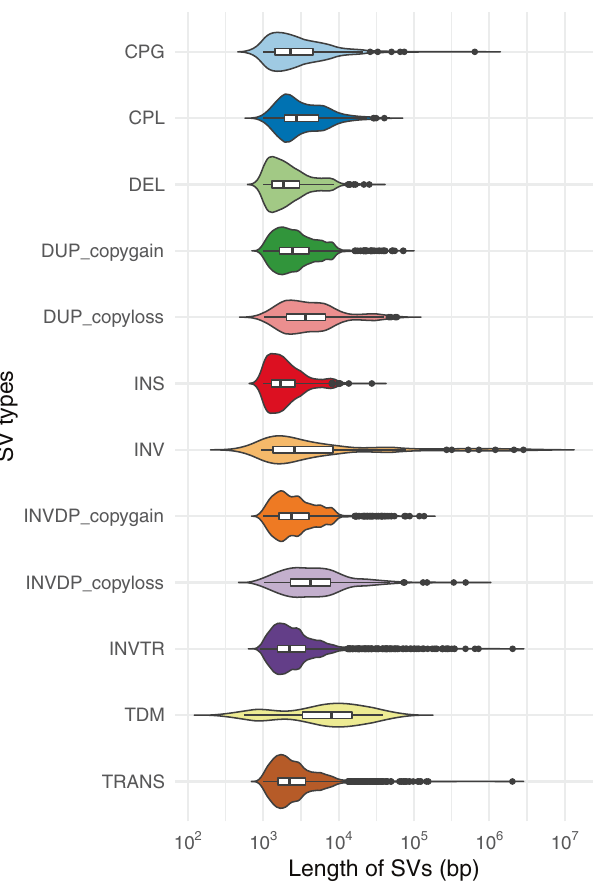
Fig. 2 Violin plots of SVs lengths distributions between iM line and iBS90 genome assemblies. CPG: copy gain in query, CPL: copy loss in query, DEL: deletion in query, DUP: duplicated region, INS: insertion in query, INV: Inverted region, INVDP: inverted duplicated region, INVTR: inverted translocated region, SYN: syntenic region, TDM: tandem repeat, TRANS: translocated